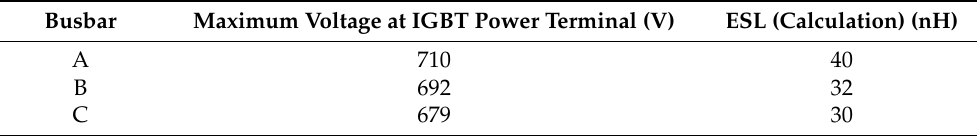
Table 2. Maximum voltage at IGBT